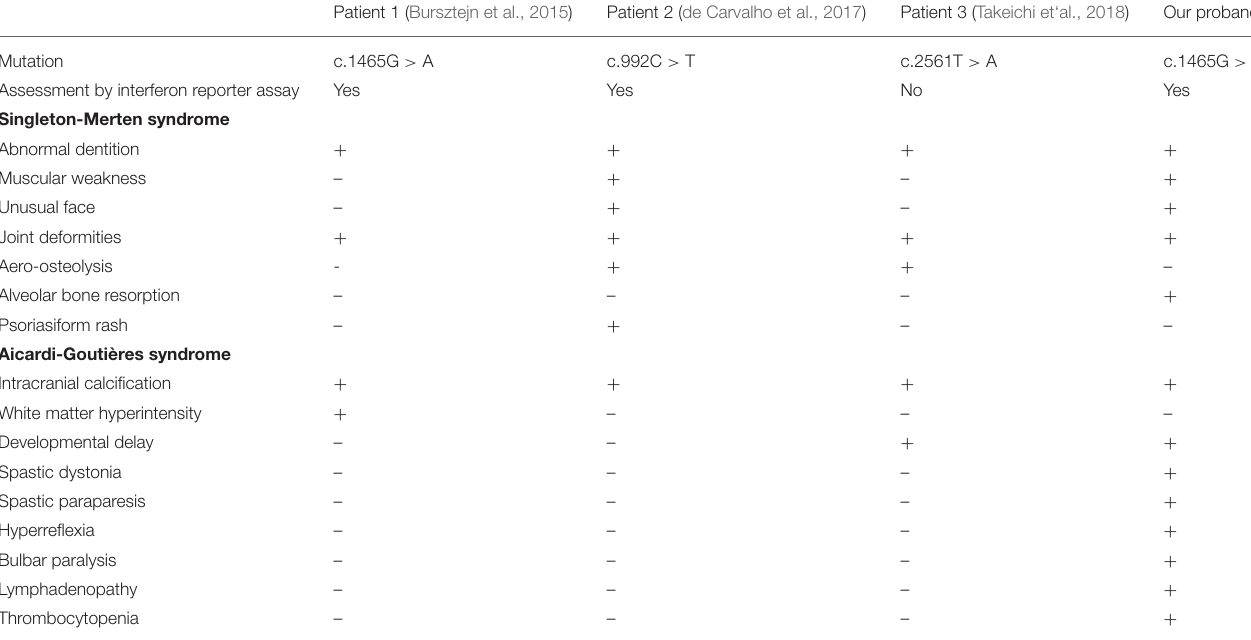
TABLE 2 | Clinical features of